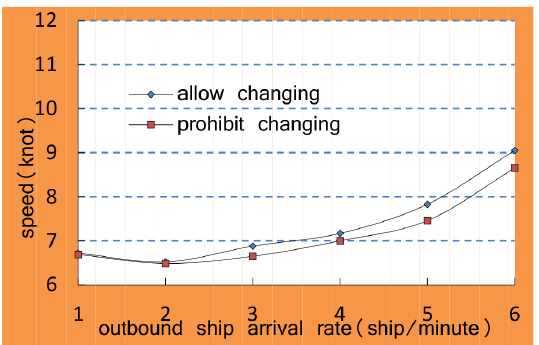
Figure 23. Average speed of waterway system and ship arrival rate as a function (inbound ship arrival rate = 4)